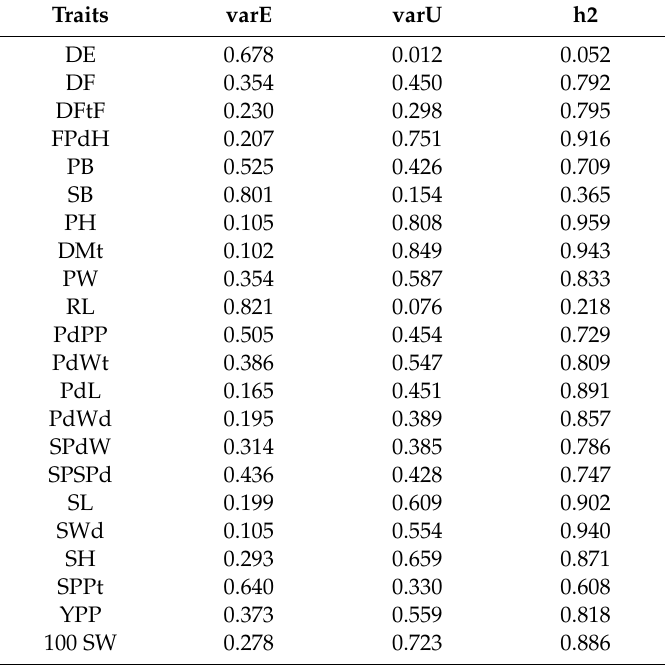
Table 2. Estimates of heritability in the Turkish common bean